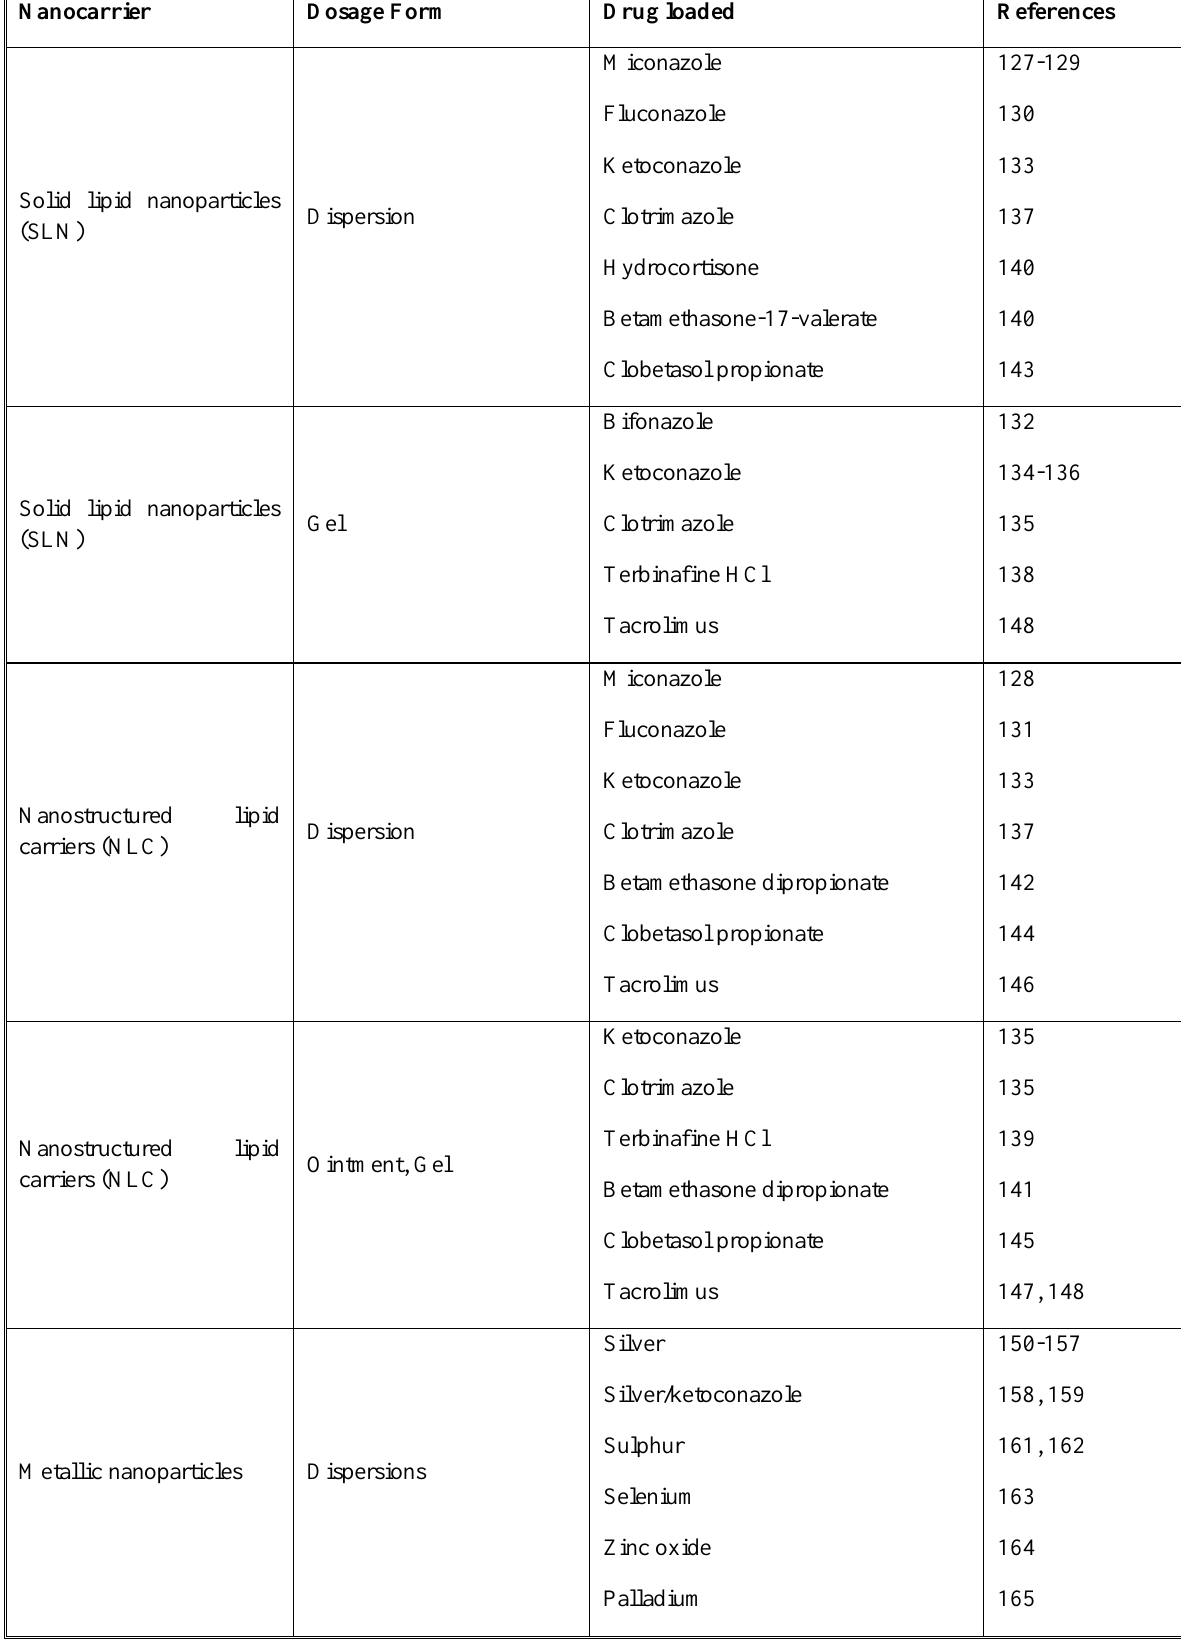
Continue Table 2. Summary of the most common nanocarriers for skin delivery of drugs used in